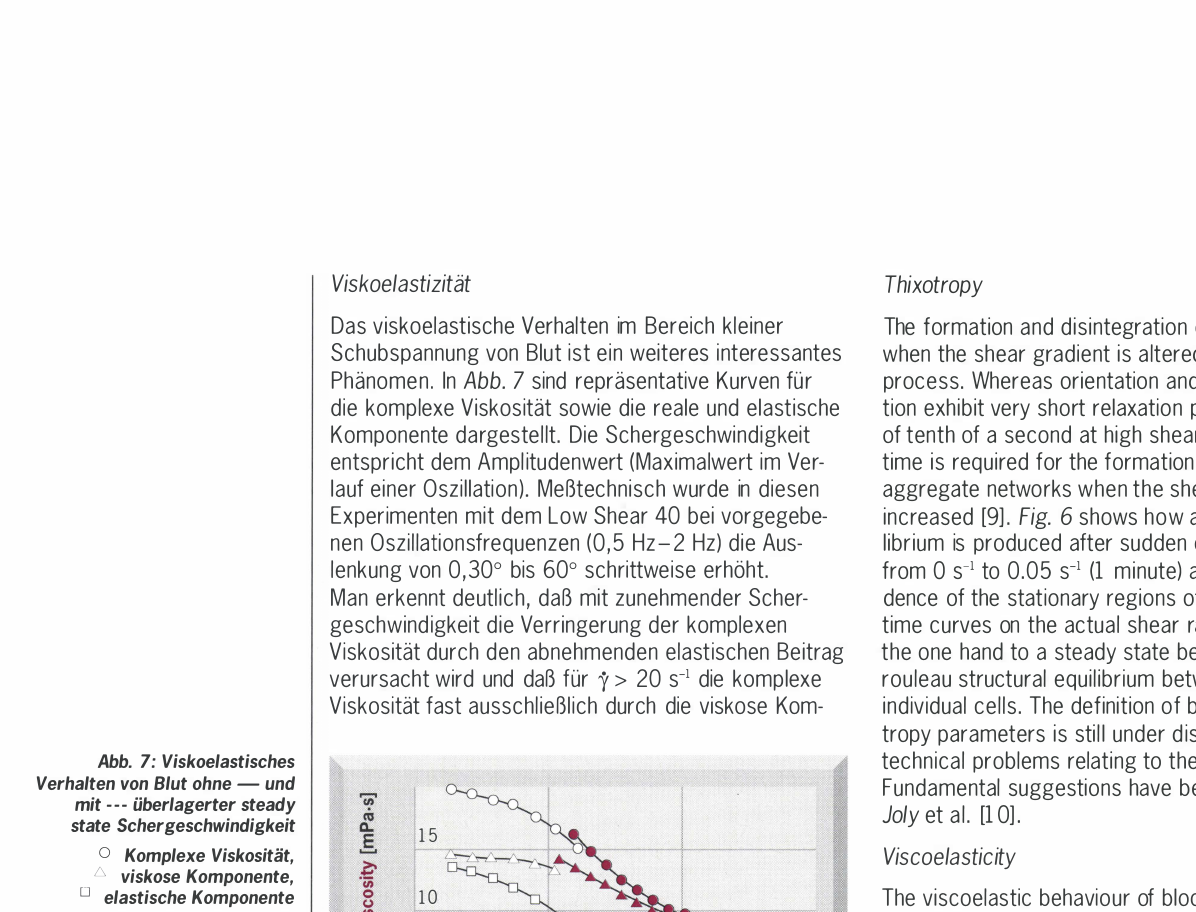
Fig. 7: Viscoelastic behaviour of blood without- and with--­ superimposed steady state shear rate. o = complex viscosity, t:o. = viscous component, 0 = elastic